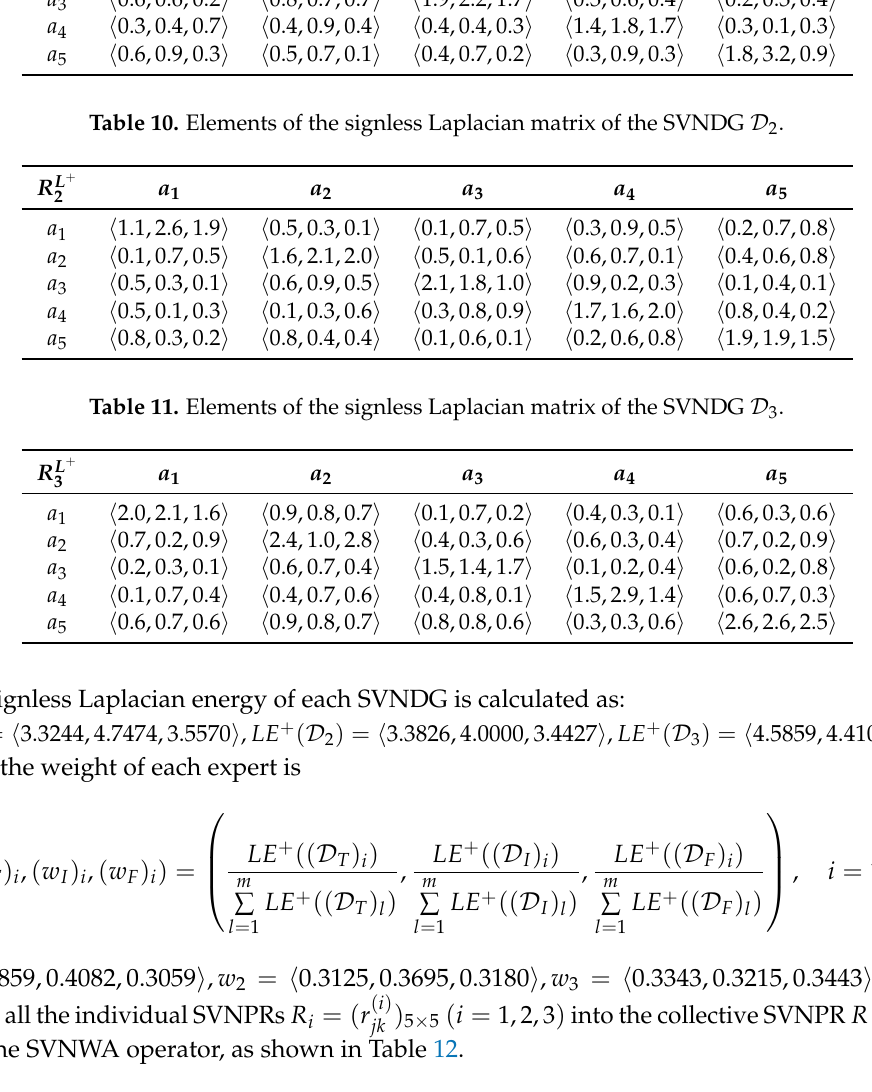
Table 9. Elements of the signless Laplacian matrix of the SVNDG